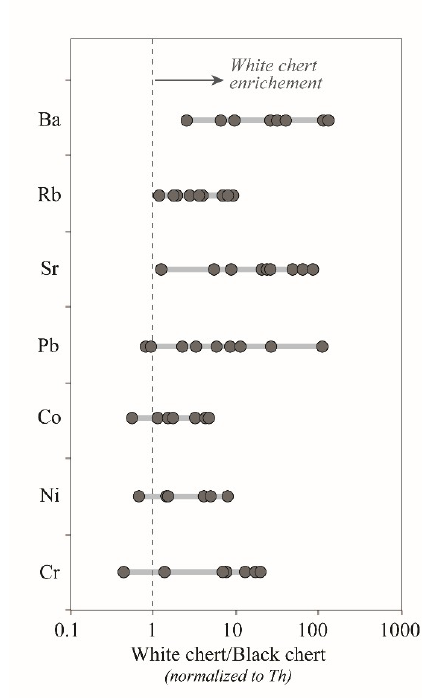
Figure 13. Comparison of black and white chert trace element composition. Elements of the y-axis are normalized to Th. White cherts are significantly enriched in Ba, Rb, Sr, Pb, and to a lesser extent in Co, Ni and Cr. The degree of enrichment strongly varies from one black-white chert couple to the other.